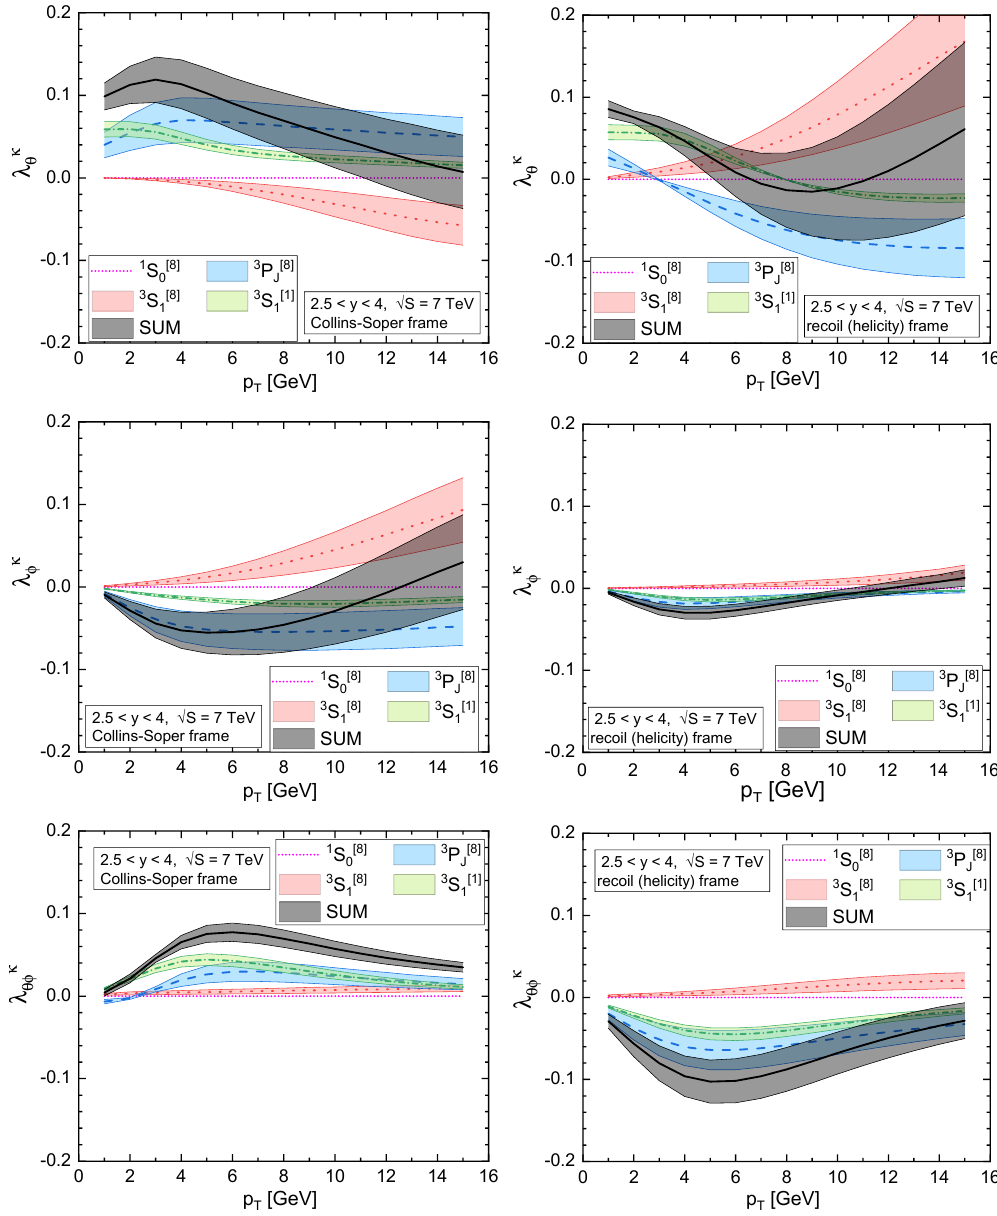
Figure 8 . Parameters (cid:21) (cid:20) ((cid:12)rst row), (cid:21) (cid:20) (second row) and (cid:21) (cid:20) (third row) de(cid:12)ned in eq. (C.1) (cid:18) (cid:30) (cid:18)(cid:30) plotted for the Collins-Soper frame (left column) and recoil frame (right column). Di(cid:11)erent colors of bands represents di(cid:11)erent channels. \SUM" (denoted as black band) represents sum of all channels, so is equal to (cid:21) (cid:18) , (cid:21) (cid:30) , (cid:21) (cid:18)(cid:30) from (cid:12)gure 2 (note the di(cid:11)erence in scales between these plots and those from (cid:12)gure